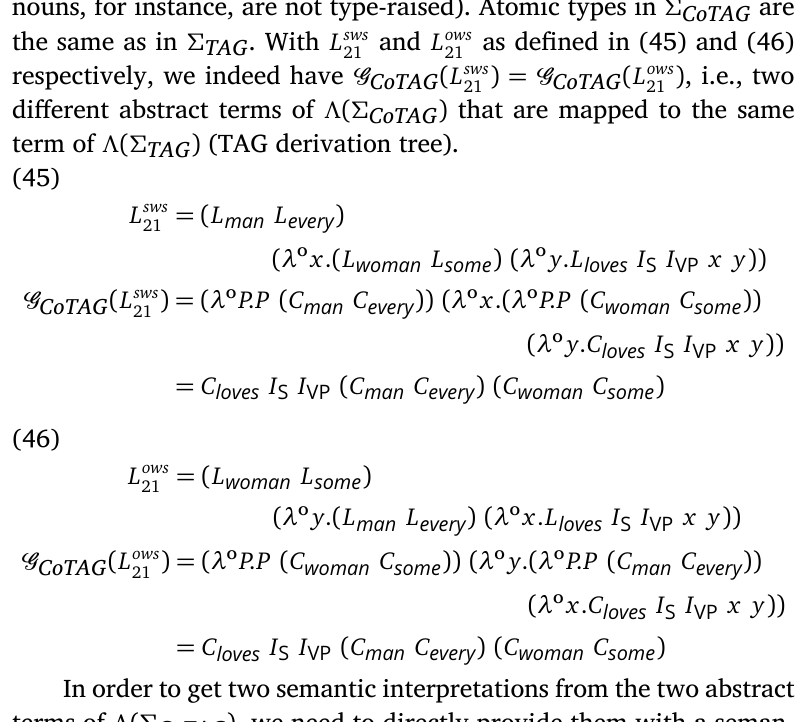
Table 24 defines the G co-sem. interpretation into terms of (cid:3)((cid:6) logic )